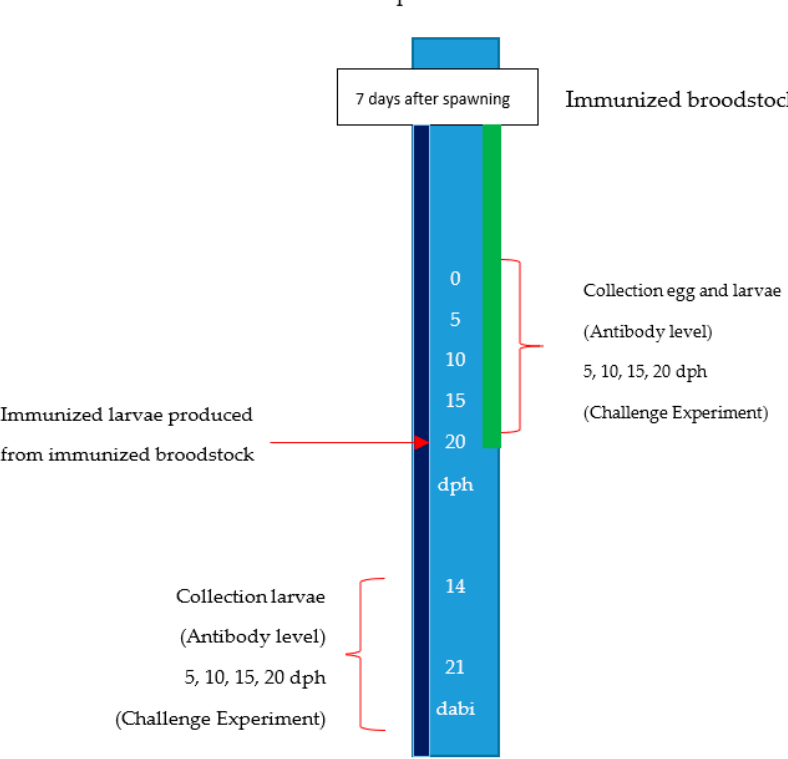
Figure 3. Diagram for the study concerning transfer maternal immunity from Nile tilapia broodstock to offspring following broodstock immunized and immunized larvae produced from immunized broodstock. Dph: days post hatch, dabi: days after broodstock immunization.